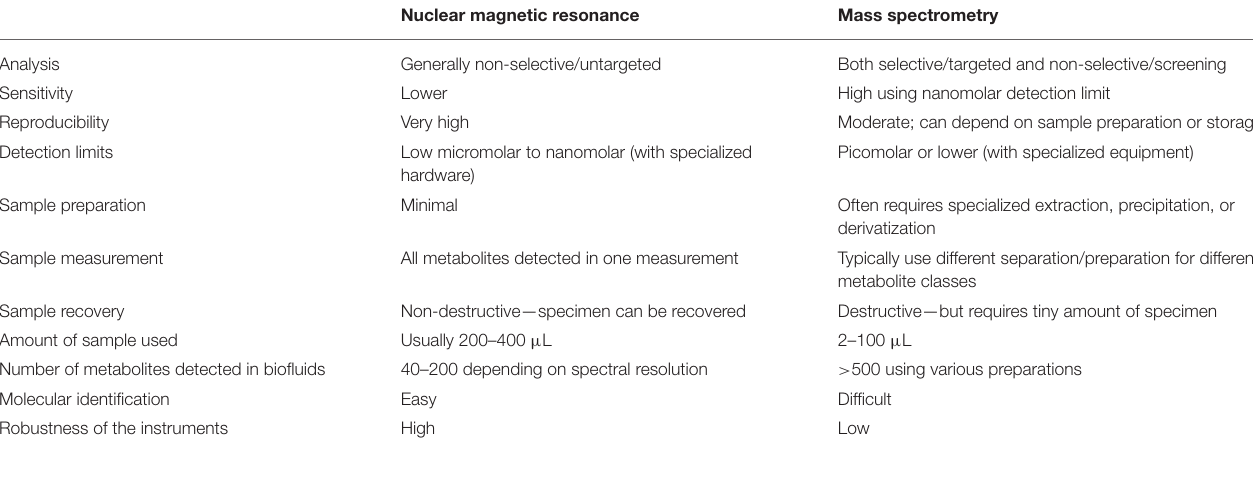
TABLE 1 | The advantages and limitations of NMR spectroscopy and MS spectrometry as an analytical tool for metabolomics research.